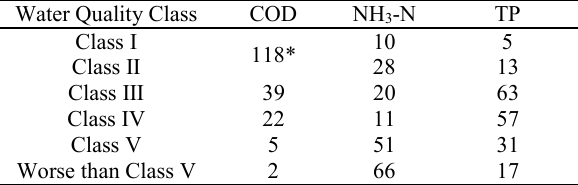
Table 1. Class distribution of each water quality index of the samples